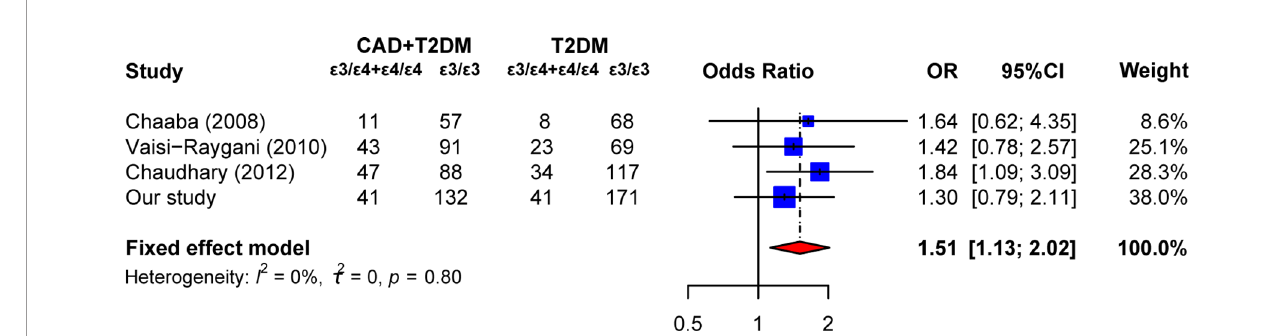
FIGURE 2 | Summary estimates of the association between the APOE ϵ 4 mutation ( ϵ 3/ ϵ 4+ ϵ 4/ ϵ 4 vs. ϵ 3/ ϵ 3) and the risk of coronary artery diseases in type 2 diabetes patients. Each study is displayed by a square whose center represents the odds ratio (OR), the area of the square is proportional to the weight of studies, and the horizontal line indicates the 95% con fi dence